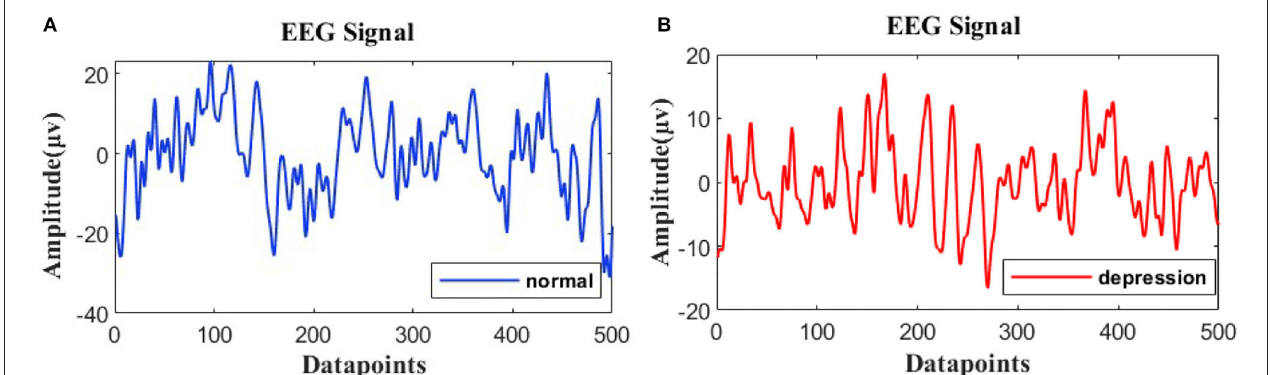
FIGURE 1 | Electroencephalogram (EEG) signals from (A) normal and (B) depressed